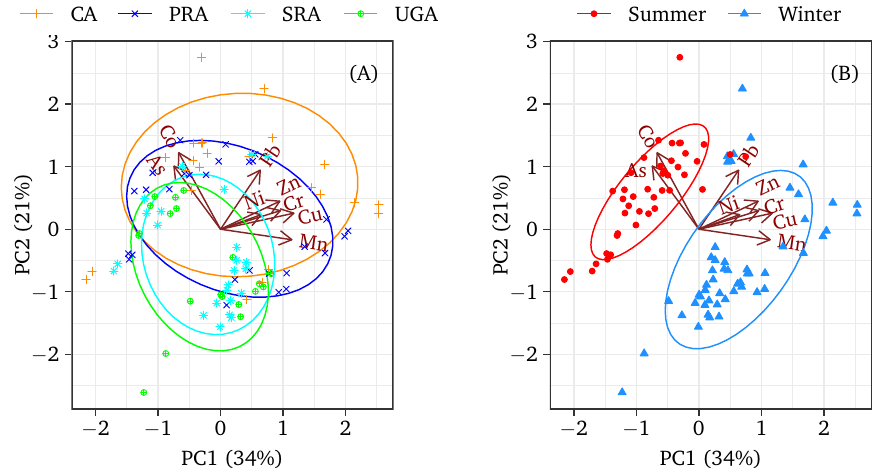
Figure 4. Principal component analysis (PCA) of heavy metal contamination of roadside dust in Dhaka city based on ( A ) land use category, and ( B ) season. CA = commercial area, PRA = planned residential area, SRA = spontaneous residential area, and UGA = urban green